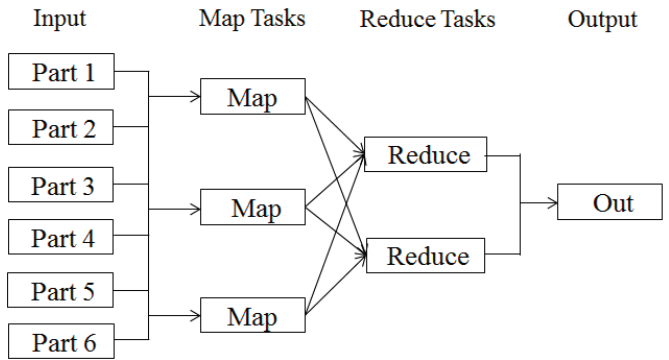
Figure 1. The operation process of MapReduce